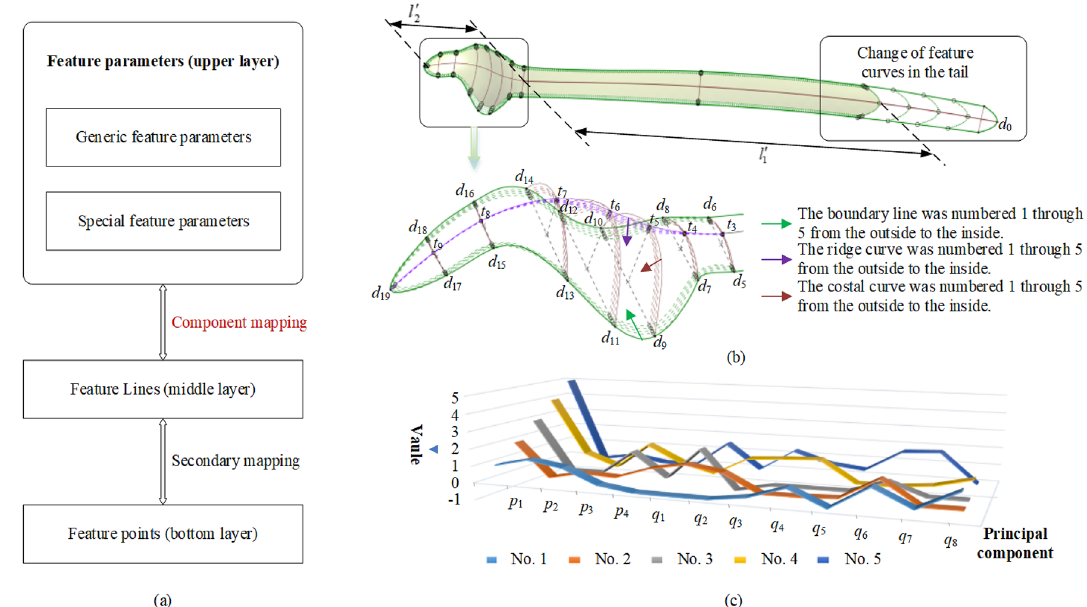
Figure 6. Undersurface feature change of the eagle-shaped plate. ( a ) Mapping relation of the feature model. The upper layer containing the feature parameters can be constructed based on the bone information. Through the component mapping and secondary mapping, the correspondence between the feature parameters and the underlying element is established, allowing the feature parameters to uniquely determine the feature geometric shape, ( b ) change of feature curves. The tail and head parameters change based on different principal component values. The feature curve approaches inward under the constraints of boundary and internal auxiliary feature curves, and ( c ) principal component values of numbered curves 1–5 shown in ( b ).